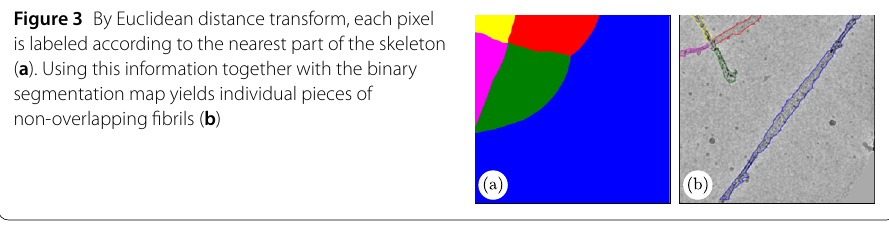
Figure 3 By Euclidean distance transform, each pixel is labeled according to the nearest part of the skeleton ( a ). Using this information together with the binary segmentation map yields individual pieces of non-overlapping fibrils ( b